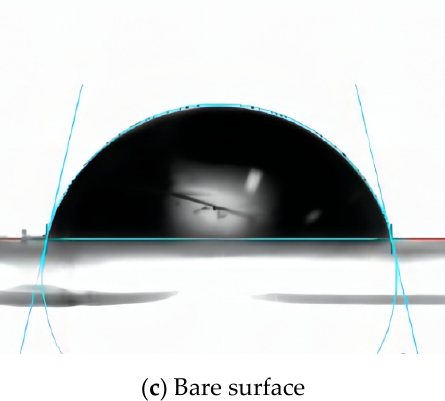
Figure 4. Contact angles of solar cell covering glass with and without coating. Figure 5. Contact angles of solar cell covering glass with and without